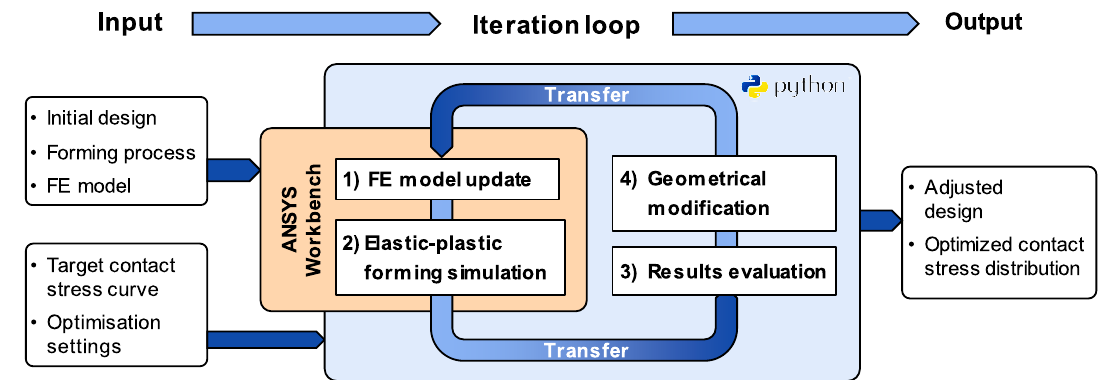
Fig. 2. Iterative design adaptation for plastically stressed shaft-hub connections, yielding optimised contact-stress distribution [1].